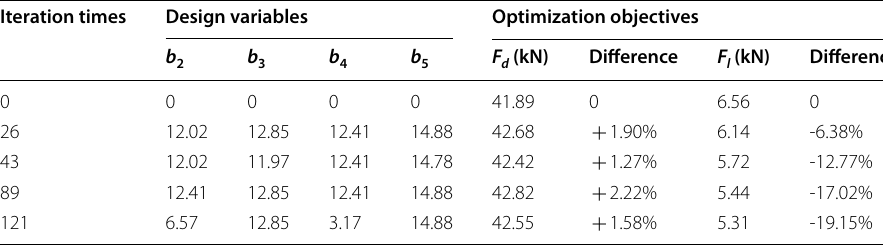
Table 3 Design variables and corresponding optimization objectives values Iteration times Design